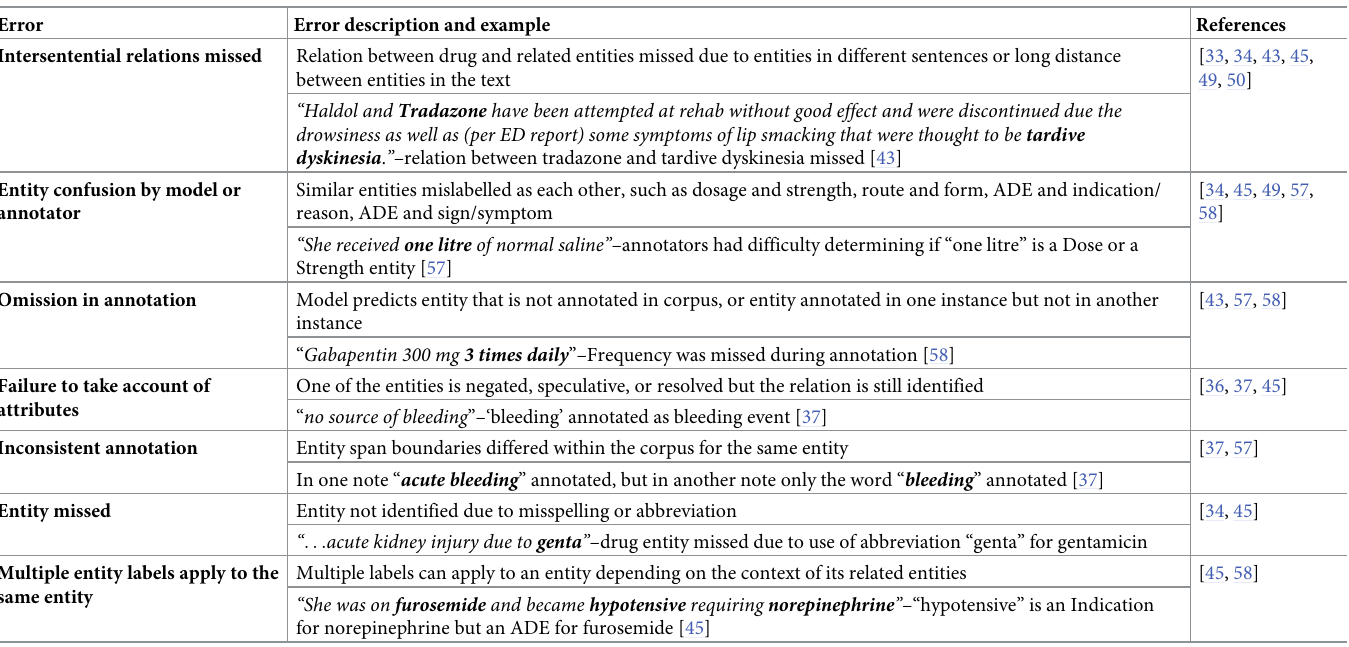
Table 6. Common errors described in error